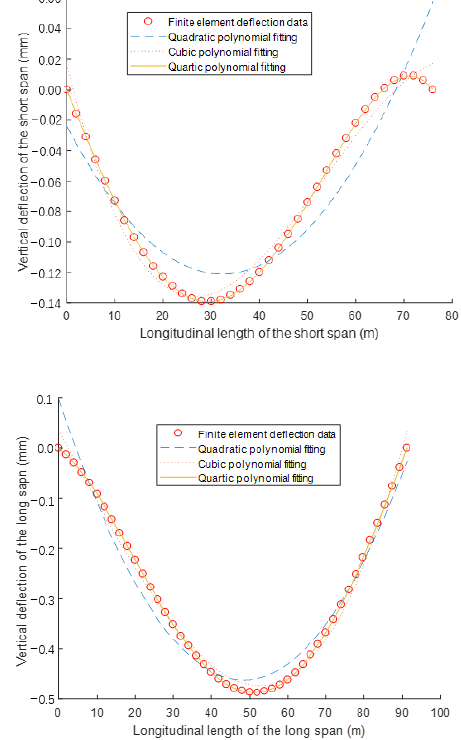
Figure 6. Fitting results of deflection curves. Materials 2022 , 15 , x FOR PEER REVIEW